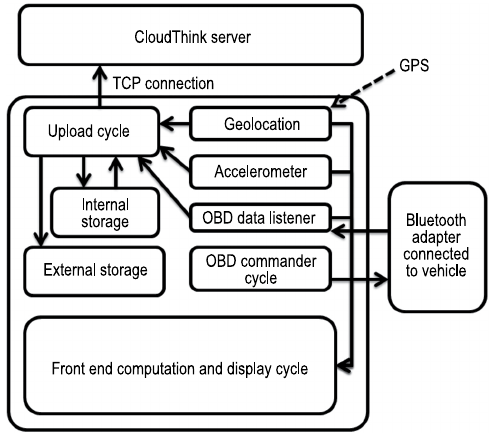
Fig. 3. Overview of the CloudThink smartphone-based software system architecture (the same data flows described in the API section have been recreated in this SmartPhone application)